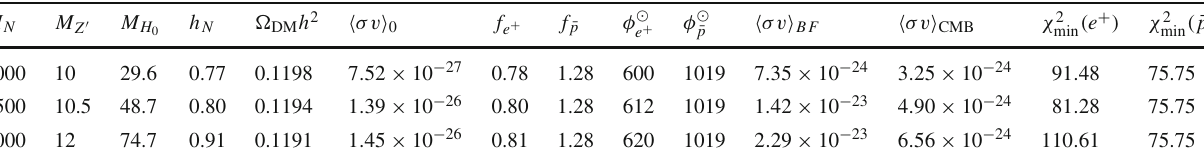
Table 4 Similar with Table 3, but for N N → Z (cid:3) H 0 annihilation chan- nel. Here we set g (cid:3) = 3 × 10 − 3 which is compatible with the LHC Z → 4 μ direct search limit for light Z (cid:3) boson. The values of M H